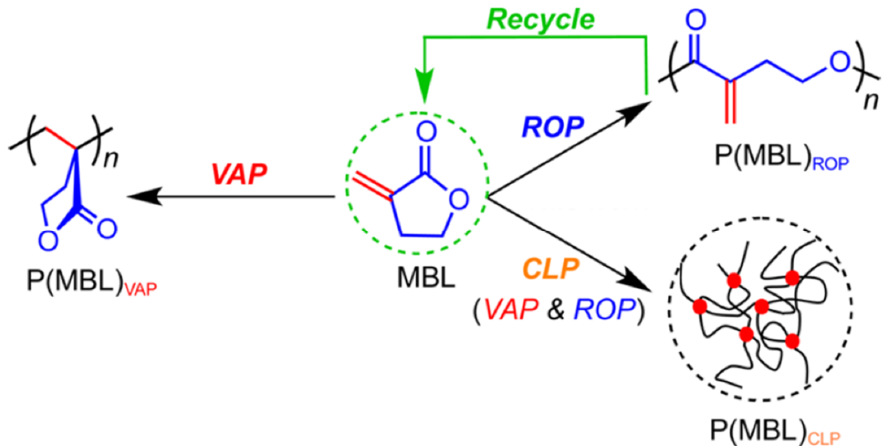
Figure 4. Reversible polymerization in ring-opening polymerization systems. Polymerization of α-Methylene-γ-butyrolactone (MBL) following three distinct mechanisms. Reproduced with permission from [69].